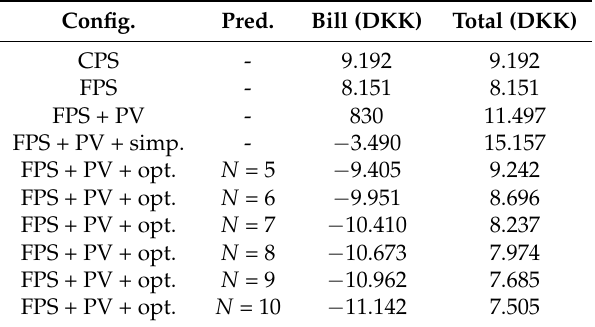
Table 4. Results from the simulated model. “Bill” is the yearly household electricity bill, and “Total” includes annual investment service (interest and back-payment). FPS, flexible pricing scheme. Config. Pred. Bill (DKK) Total (DKK) CPS - 9.192 9.192 FPS -